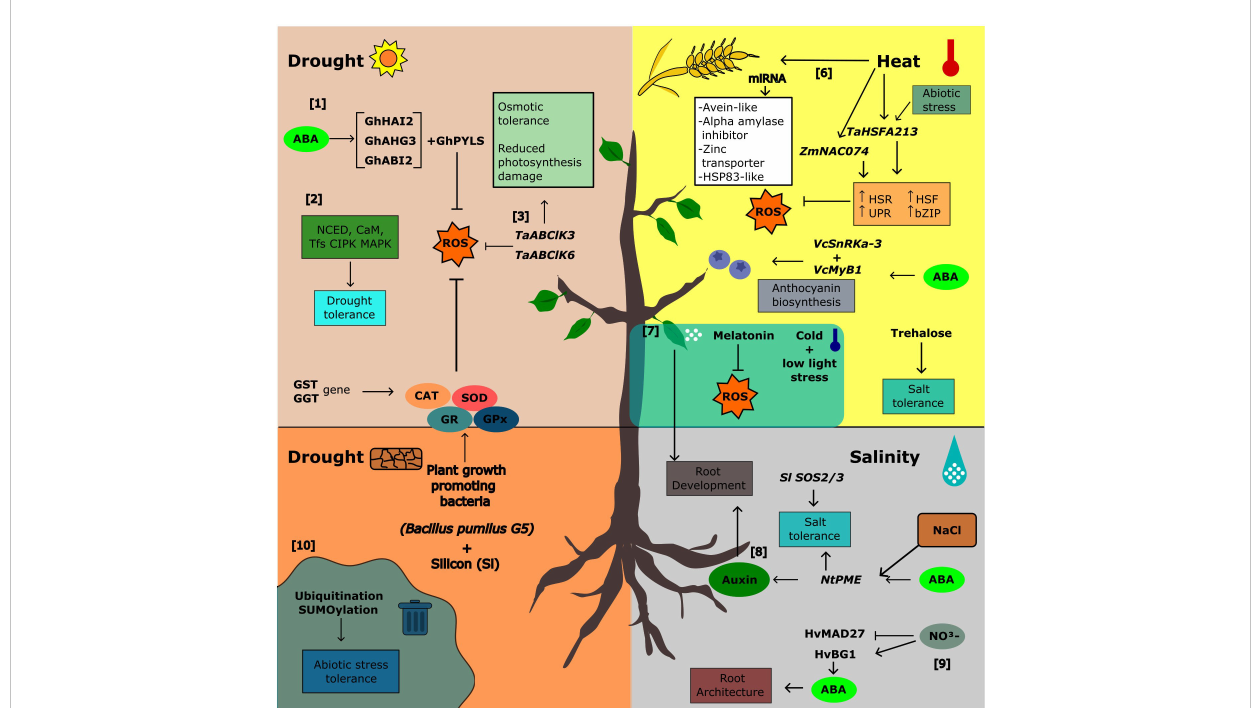
FIGURE 1 Integration of signals in abiotic stress and adaptive responses in plants. [1] The sensitivity and synthesis of ABA were regulated by the GhHAI2, GhAHG3, and GhABI2 genes in cotton (Shazadee et al.), and [2] NINE-CIS-EPOXYCAROTENOID DIOXYGENASE (NCED) and zeaxanthin epoxidase (ZEP) in two xerophytic desert trees (Yang and Lv). In these trees, signaling pathways under drought stress also involves CaM, CIPK, and MAPKK genes (Yang and Lv), and [3] overexpression of TaABC1K3 and TaABC1K6 in Arabidopsis and wheat improved drought tolerance (Gao et al.) by inducing osmotic tolerance and reduced photosynthetic damage. In addition, drought stress tolerance is also promoted by [4] application of plant growth-promoting bacteria (PGPB) and silicon (Si) which increase antioxidant enzymes such as catalase (CAT), superoxide dismutase (SOD), GR, and GPx and regulate GST and GGT genes in Glycyrrhiza uralensis (Ma et al.). [5] Low light and low-temperature stress could be mitigated by melatonin foliar application in pepper by controlling root development and ROS production (Li et al.). [6] In heat stress, ZmNAC074 from maize (Xi et al.) and TaHsfA2-13 from wheat (Meng et al.) were important genes related to heat shock response (HSR), unfolded protein response (UPR), basic leucine zipper (bZIP), heat shock proteins (HSP), and reactive oxygen species removal, conferring tolerance to these plants. Heat stress tolerance has also been observed through the upregulation of avenin-like cysteine-rich storage proteins, amylase inhibitors, zinc transporters, and HSP83-like proteins expressed by miRNA in the early stages of wheat seed development (Paul et al.). [7] In blueberry fruit, ABA is also involved in anthocyanin biosynthesis (VcMYB1 and VcSnRK2.3) (Wang et al.). [8] Modulation of root system architecture is also mediated by abscisic acid (ABA) in tomato (Zinta et al.) and barley (HvMADS27 x ABA) (Smoczynska et al.). NtPME genes in tobacco roots were also induced by ABA and auxin pathways, mediating root development under salinity (Sun et al.). [9] Release of ABA from conjugates can also inhibit root development under conditions of nitrogen excess in barley (Smoczynska et al.). [10] Other post-transcriptional processes such as ubiquitination and SUMOylation play an important role in tolerance to various abiotic stresses (Singh et